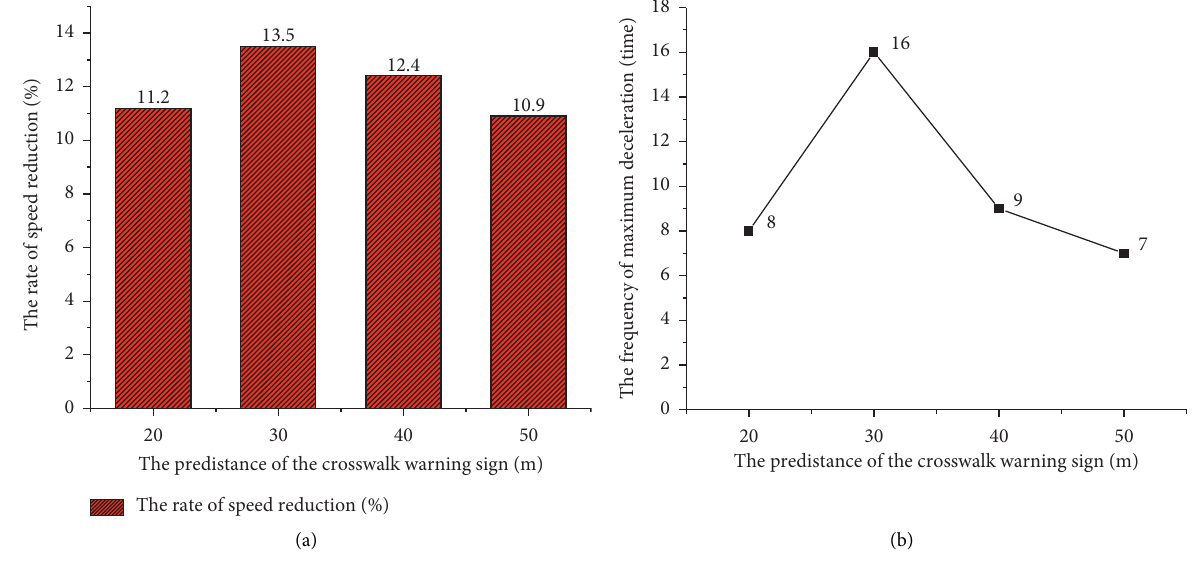
Figure 4: The rate of speed reduction and times of maximum deceleration at a design speed of 30km/h. (a) The rate of speed reduction. (b) The frequency of maximum